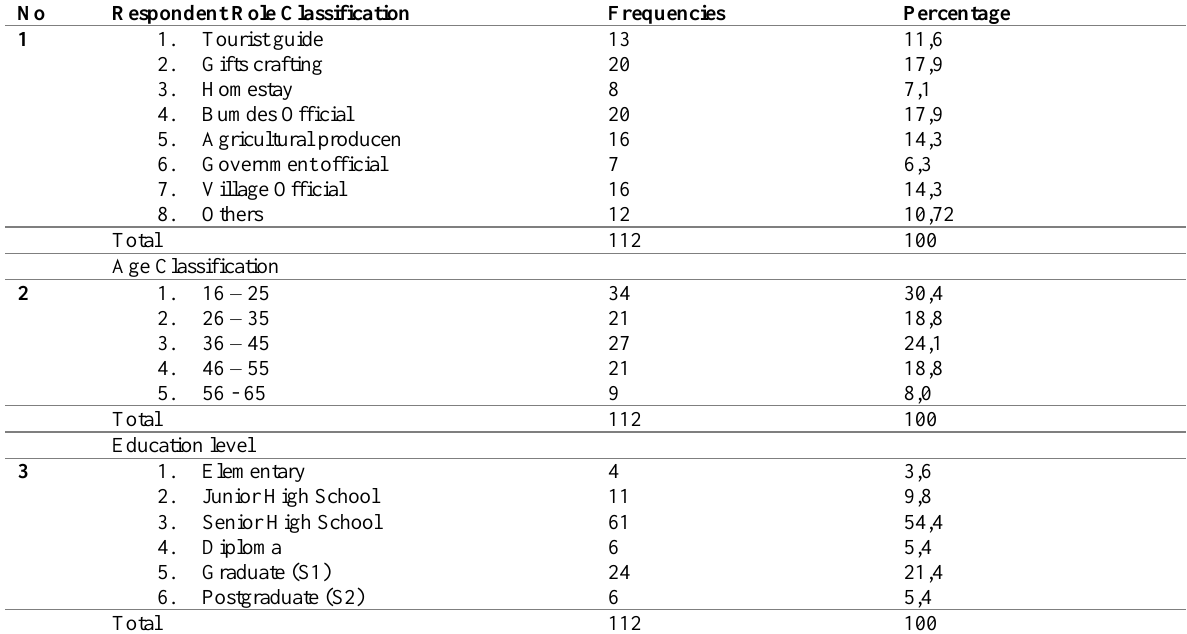
Table 1: Sample distribution including respondents’ role, age classification, and education level (n: